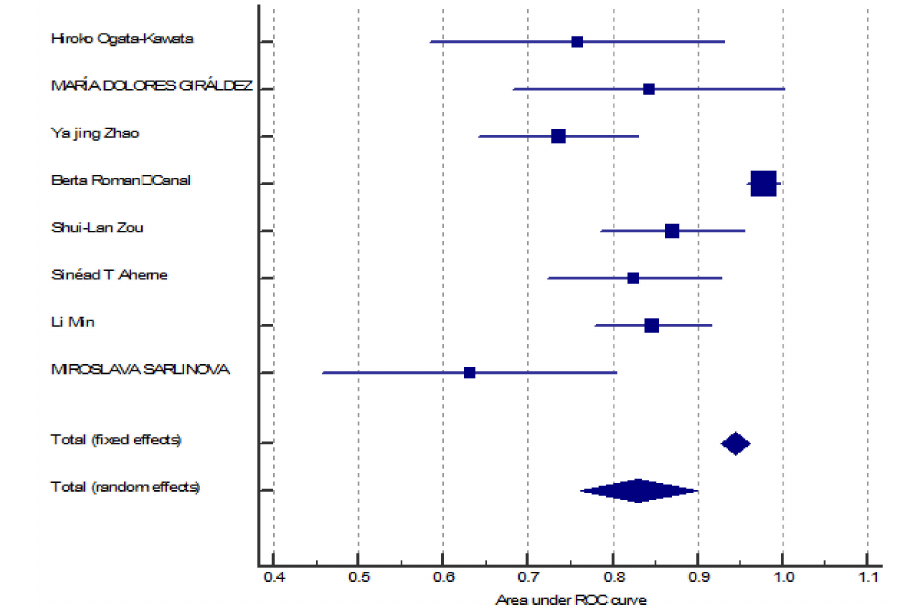
Figure 3. Forest plot for meta-analysis of AUC using a random-e ff ects